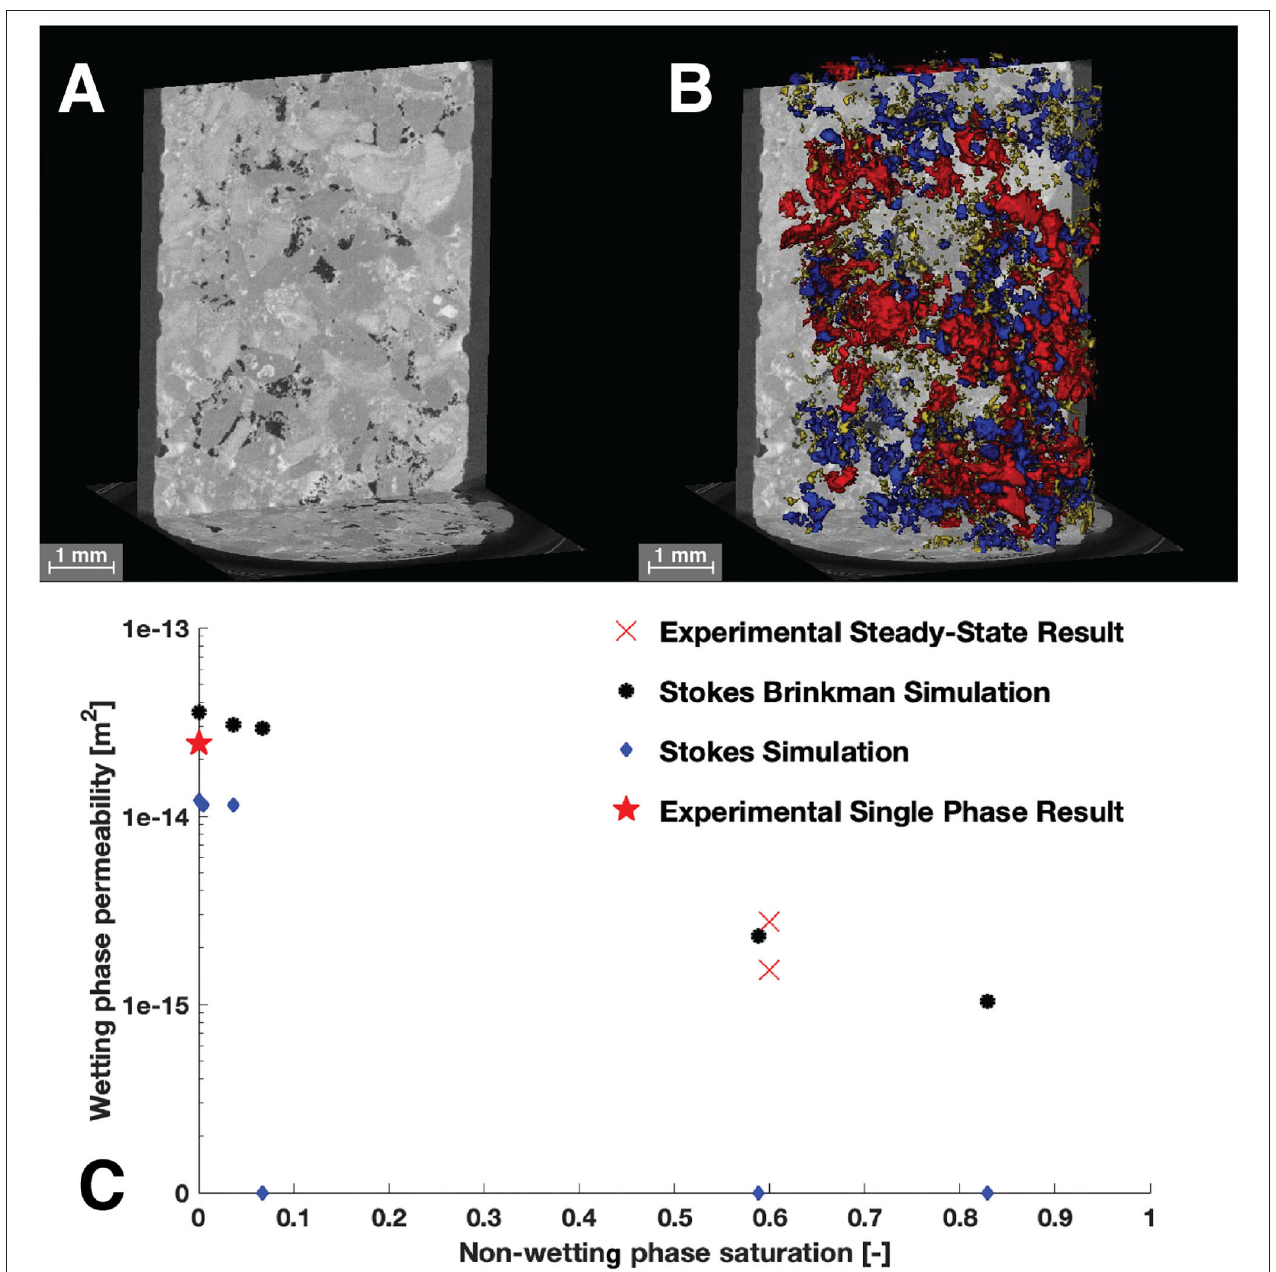
FIGURE 11 | The wet scan (A) taken during co-injection of N 2 (black) in the pore space of Estaillades. A 3D rendering of N 2 (B) sieved by size with small (yellow), medium (blue), and large (red) disconnected clusters. The WP permeability is plotted as a function of NWP saturation (C) with the Stokes simulation in blue, the S–B in black, the experimental results from the single phase shown as a red star, and the result from steady-state co-injection as a red cross. ( Figure 12 ). The flow rate was varied to provide a more accurate error